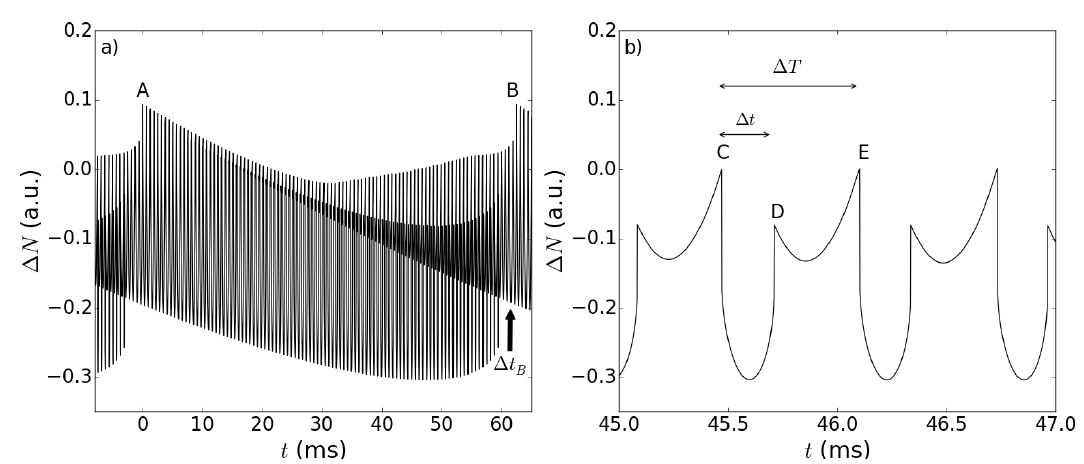
Figure 3. Typical temporal trace of the carrier density difference ∆ N as a function of time. = 5 . 0 × 10 − 3 m/s and v = 5 . 0 × 10 − 5 m/s, Reference and object target velocities are v r o = 0 . 029 and k = 0 . 025 . ( a ) A complete respectively, while feedback parameters are k r o slow fringe, delimited by Points A (at t = 0 ms) and B (at t = 62 ms), is shown, so that the faster modulation induced by the reference target is evident; in addition, the time interval of sub-feature disappearance ( ∆ t ), introduced in Section 3.3, is represented. ( b ) A close B up, for a shorter time interval, of the temporal trace shown in (a), where the fast fringe can be identified (between Points C and E), with its associated time interval, denoted by ∆ T . The sub-feature is delimited by Points D and E, and the time interval ∆ t between two consecutive sub-features is the physical quantity on which the sensing scheme is based. The other parameters are reported in Table 1.